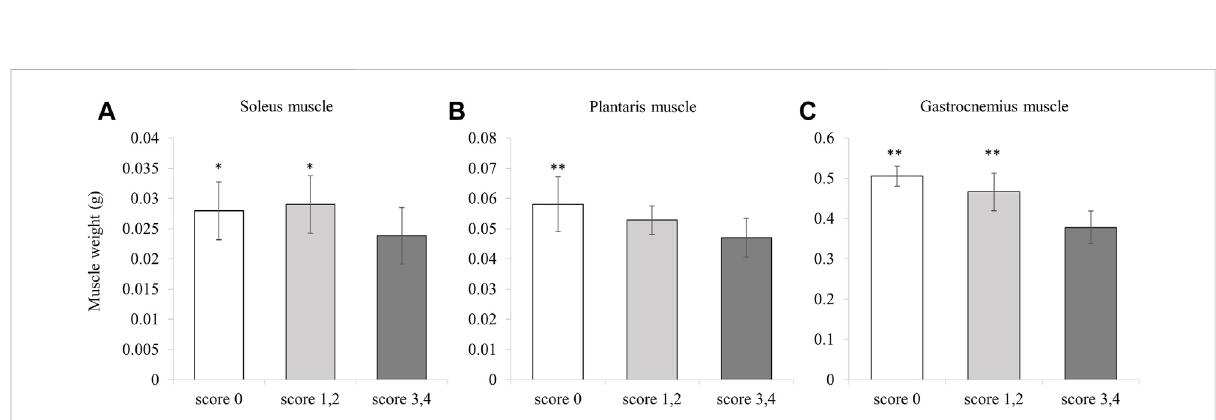
FIGURE 6 EffectofNYTonmuscleweightinsamescoregroup. (A) Soleusmuscle. (B) Plantarismuscle. (C) Gastrocnemiusmuscle(Numberoflegs;Score 0 n = 14, score 1,2 n = 8, score 3,4 n = 34). Values are expressed as means ± S.D. p p < 0.05, pp p < 0.01 vs score 3,4 group by dunnett